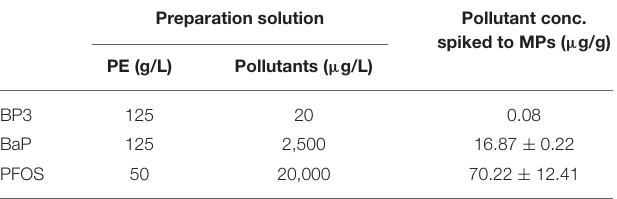
TABLE 4 | Concentrations of MPs and pollutants (mean ± SD) in solution and the resulting concentration of the pollutants on the PE particles ( n = 1 for BP3 and n = 3 for BaP and